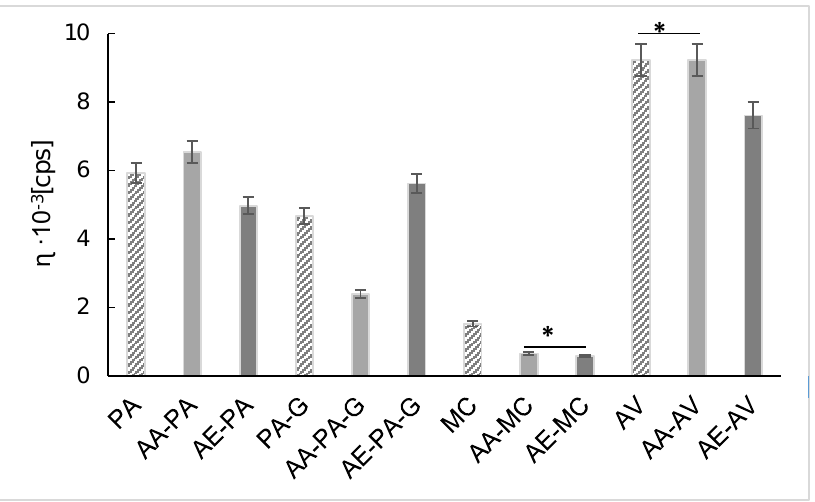
Figure 5. The viscosities of preparations AA – PA, AA – PA – G, AA – MC, AA – AV, AE – PA, AE – PA – G, AE – MC and AE – AV at a temperature of 20 °C. Asterisk (*) indicate no differences ( p > 0.005, ANOVA test) between AA – MC and AE – MC and AV and AA – AV preparations.